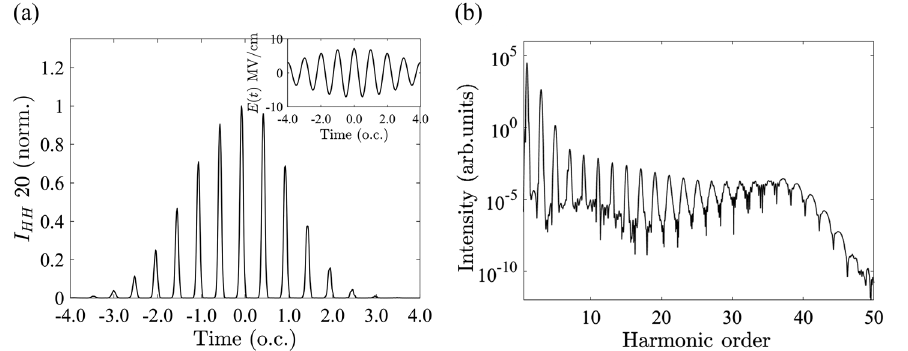
FIG. 8. HHG of the KM model with inversion symmetry. (a) Temporal structure of the 20th order HHPTs. The inset shows the corresponding laser-field strength. (b) High-harmonic spectrum with pure odd-order harmonic